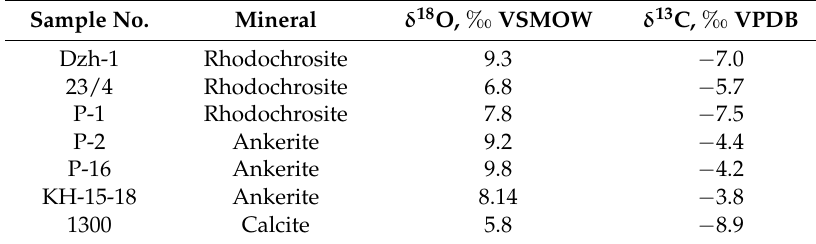
Table 4. The δ 18 O and δ 13 C values in carbonate minerals from the Kholtoson deposit.